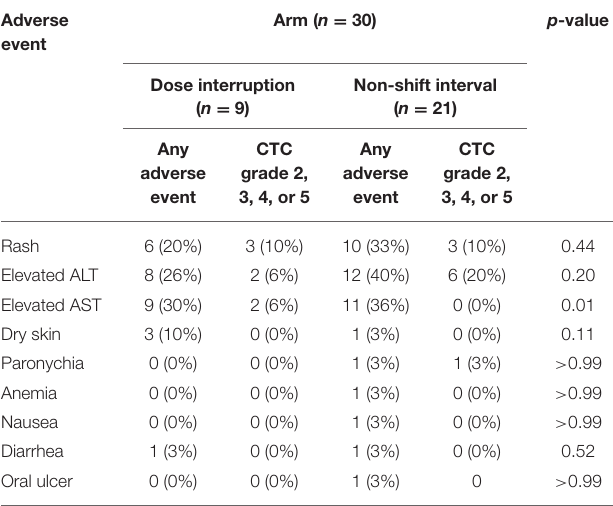
TABLE 3 | Maximal adverse event for the dose interruption and non-shift interval groups.